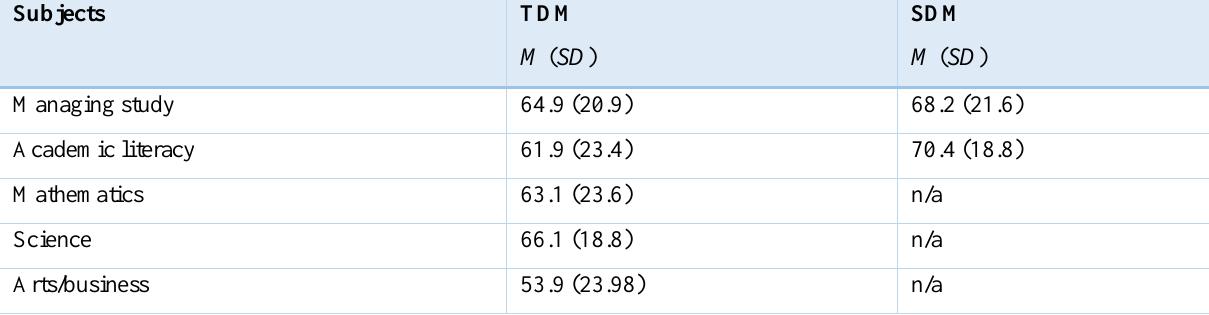
Participants’ Academic Performance Indicated by Mean Final Scores in the Subjects in the TDM and the SDM Subjects